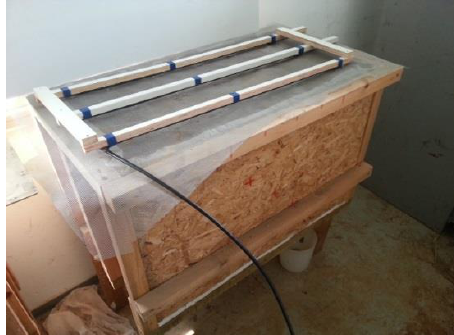
Figure 3. Soil box for laboratory irrigation experiment.